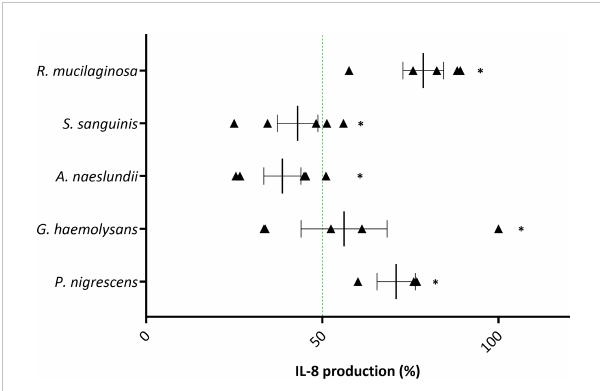
FIGURE 6 Anti-in fl ammatory activity of selected lung commensals with 1 mM H 2 O 2 as pro-in fl ammatory stimulus in (3D) A549 cells based on IL-8 secretion. Selected lung commensals at their mMOI IL-8 , in presence of H 2 O 2 , were evaluated for anti-in fl ammatory activity using an ELISA for IL-8 quanti fi cation. On the vertical axis the tested species are shown. On the horizontal axis the % IL-8 production compared to H 2 O 2 -stimulated cells is shown. Anti-in fl ammatory activity was de fi ned as:< 50% IL-8 production compared to H 2 O 2 -stimulated cells as visualized by a green line, p< 0.05. *: p< 0.05, n ≥